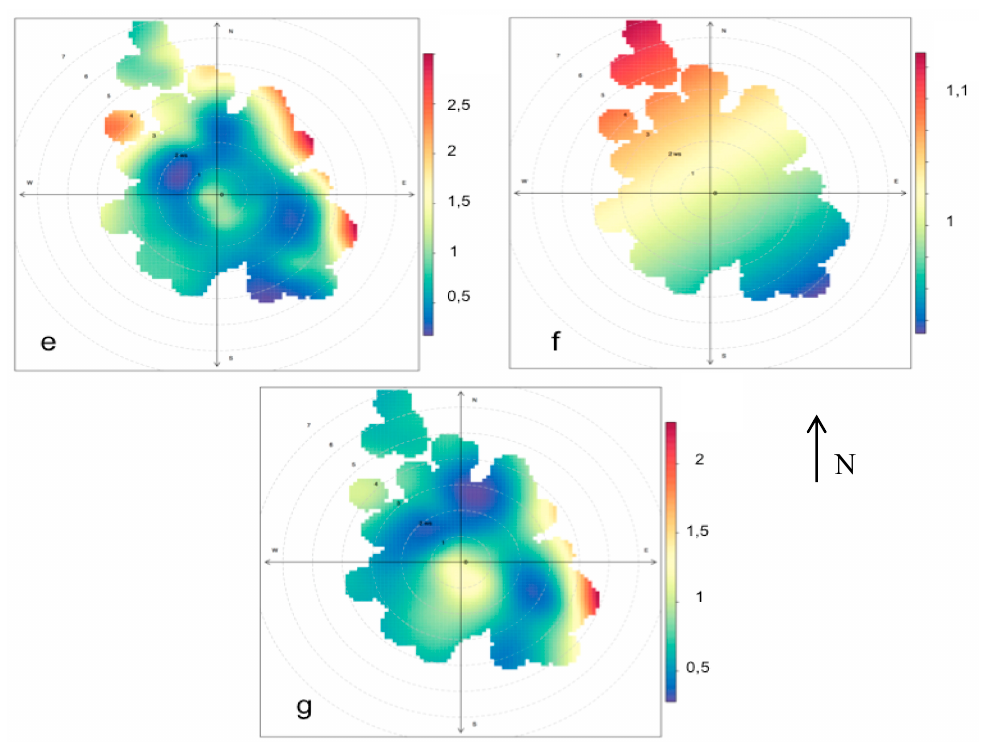
Figure 5. Contribution of the seven sources depending on wind: ( a ) industrial solvents, ( b ) combustion of coal, ( c ) vehicular emissions, ( d ) pesticides, ( e ) liquefied petroleum gas, ( f ) industrial emissions, and ( g ) refrigerants. The graphs were generated using Openair in R programming (Carslaw and Ropkins, 2012).